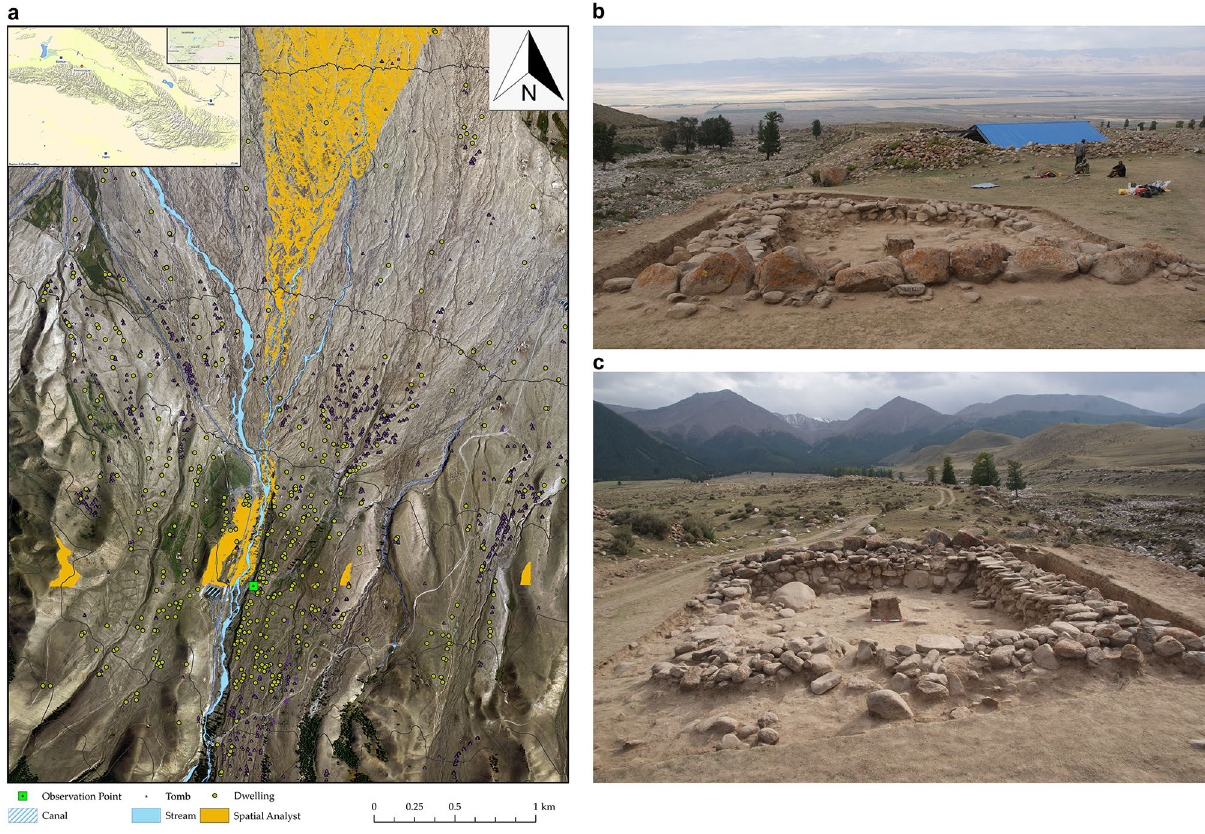
Figure 4. ( a ) Satellite map of the Shirenzigou site showing the location of the site. The other dwellings (yellow circles) and tombs (purple triangles) identified at the site are also marked. The viewshed from the north door of the dwelling is shown in orange. The map was created by D. L. and F. M. using ArcGIS 10.2 https:// www. esri. com. The base map is the aeral photograph taken during our survey in 2010. ( b ) View from the south of the excavation looking north over the fluvial plain, note the river bed to the left. ( c ) View from the north of the dwelling looking south towards the mountains. Photograph credit: J. M.